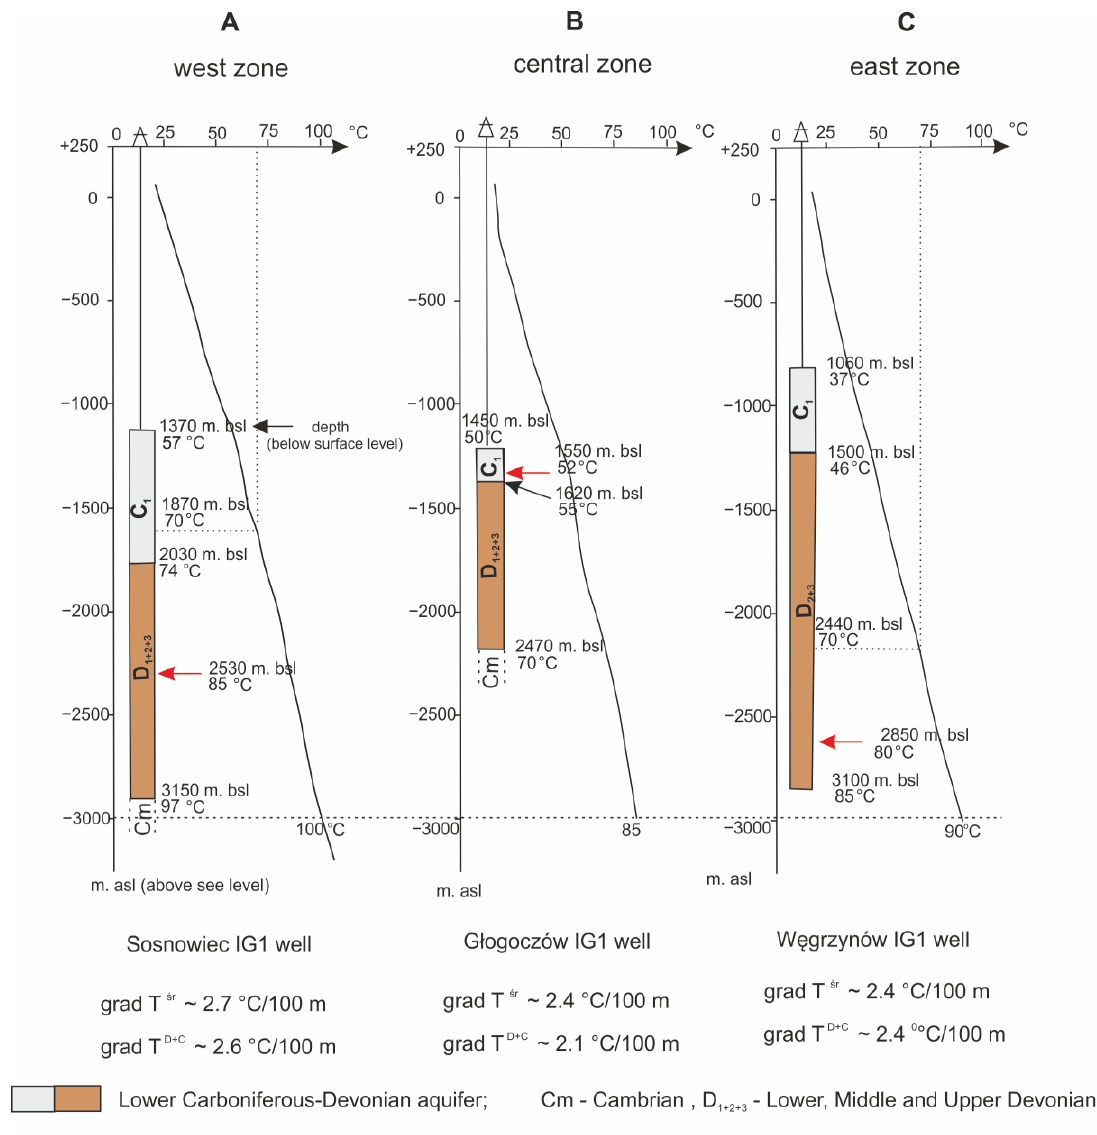
Figure 5. Stratigraphic column together with results of temperature-log interpretation in wells for each of the three separated zones: ( A ) west zone, ( B ) central zone, ( C ) east zone (according to [7,23,31], location in Figure 1).